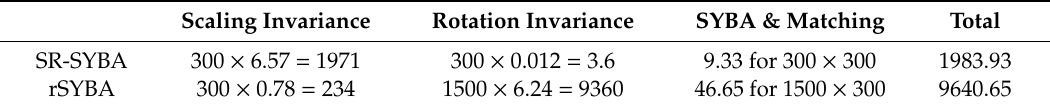
Table 2. Processing time comparison between rSYBA and SR-SYBA (in